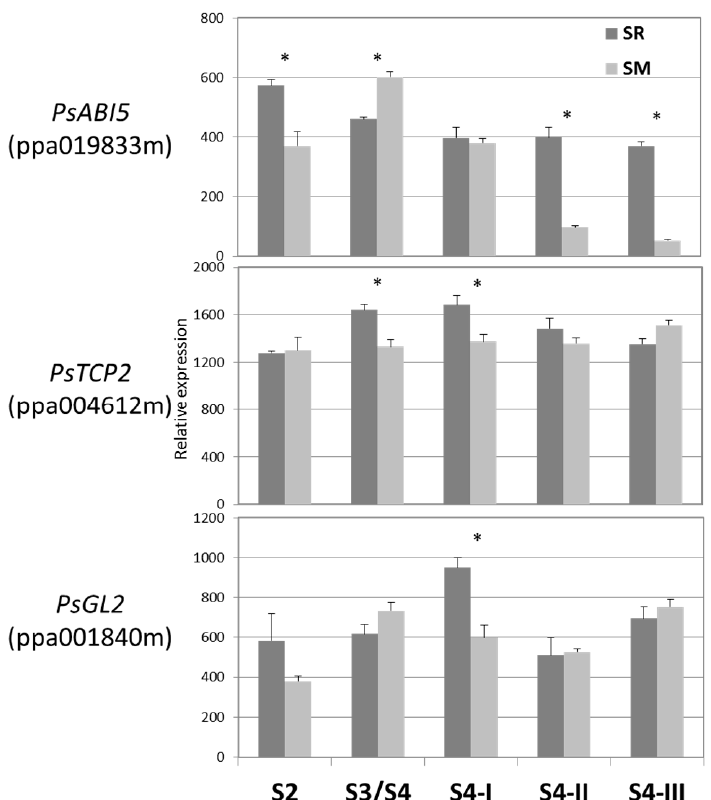
Figure 4. Expression levels of the indicated TFs (in parentheses, their Prunus persica protein ID) in climacteric Japanese plum Santa Rosa (SR) and non-climacteric Sweet Miriam (SM) during the different fruit developmental stages: S2 (pit hardening); S3/S4 (the second exponential growth phase), S4-I (commercial ripening), S4-II (fully ripen), and S4-III (overripe). Values are the mean ± SE (n = 3). (*) indicates significant difference between SM and SR in student t-test ( p ≤ 0.05).